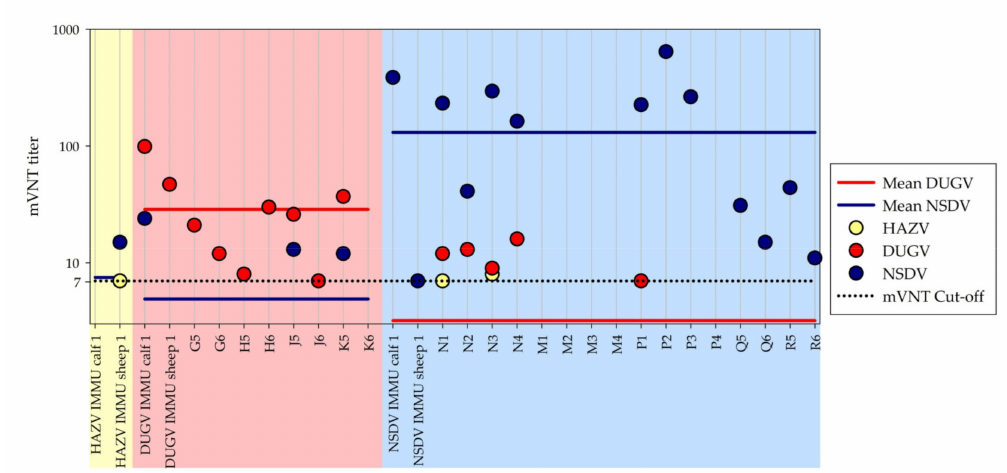
Figure 4. Cross-testing mVNT results: This figure visualizes the mVNT titers for the respective end point sera for all infected and immunized animals. The yellow, red, and blue sections show the results for the ruminants inoculated with HAZV, DUGV, and NSDV, respectively. The great majority of infected and immunized animals revealed higher mVNT titers against the homologous virus than the heterologous viruses. Mean mVNT titers were clearly higher for DUGV in the red section and for NSDV in the blue section, represented by the red and blue line, respectively. For HAZV only very weak mVNT titers were seen for some NSDV sheep.